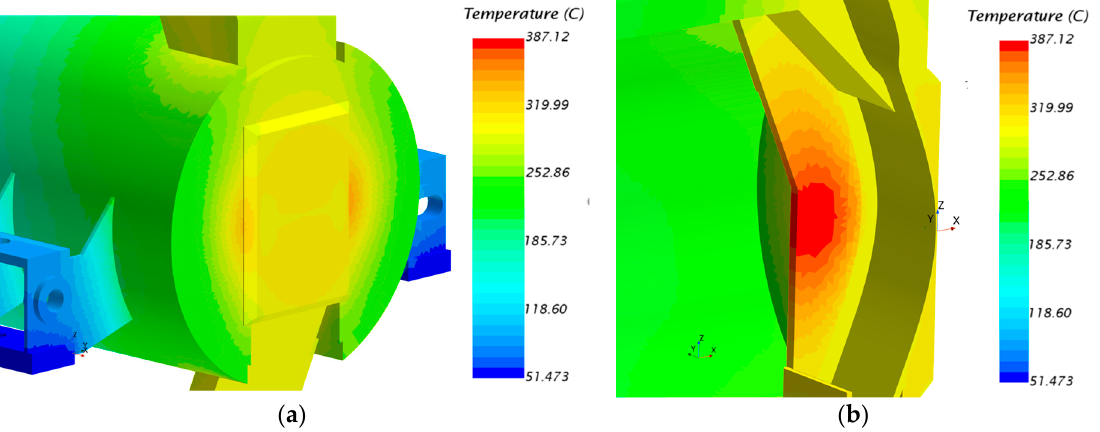
Figure 9. Temperature (°C) distribution of the TA and the BP. ( a ) isometric view; ( b ) cut-view through the TA’s center.